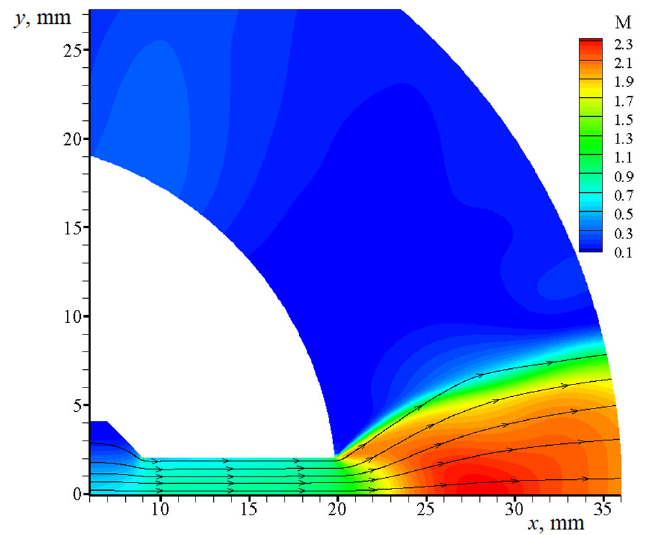
Figure 10. Calculated Mach ‐ number isolines for 0.4 mm h . The comparison of Figure 8a ( 0.2 mm h ) with Figure 10 ( 0.4 mm h ) shows that in both cases the qualitative pattern of the flow is the same. However, on increasing the inter ‐ disk spacing, the Mach number in the supersonic jet has increased, and the closing shock wave has shifted downstream. Figure 11 shows the dependences of the gas velocity u u x along the abscissa axis calculated for the ( ) u u x and the velocity of particles ( ) p p cases of 0.2 mm h and 0.4 mm h . Evidently, on increasing the inter ‐ disk spacing, the velocity of the gas flow and that of particles have both increased accordingly.